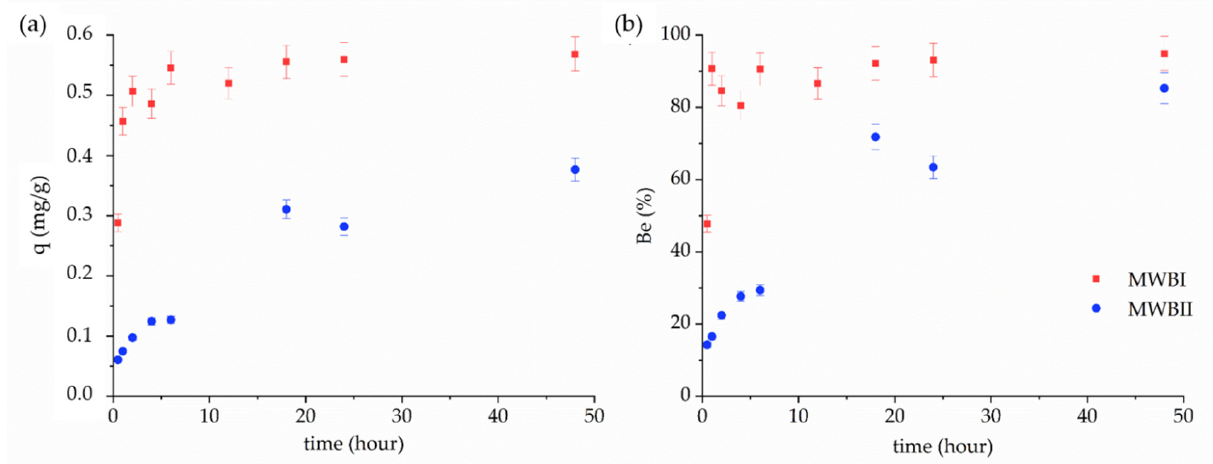
Figure 5. Kinetics ( a ) and efficiency ( b ) of Be(II) removal from aqueous solution by MWBI and MWBII; pH 4, 0.1:0.05 solid-to-liquid ratio.